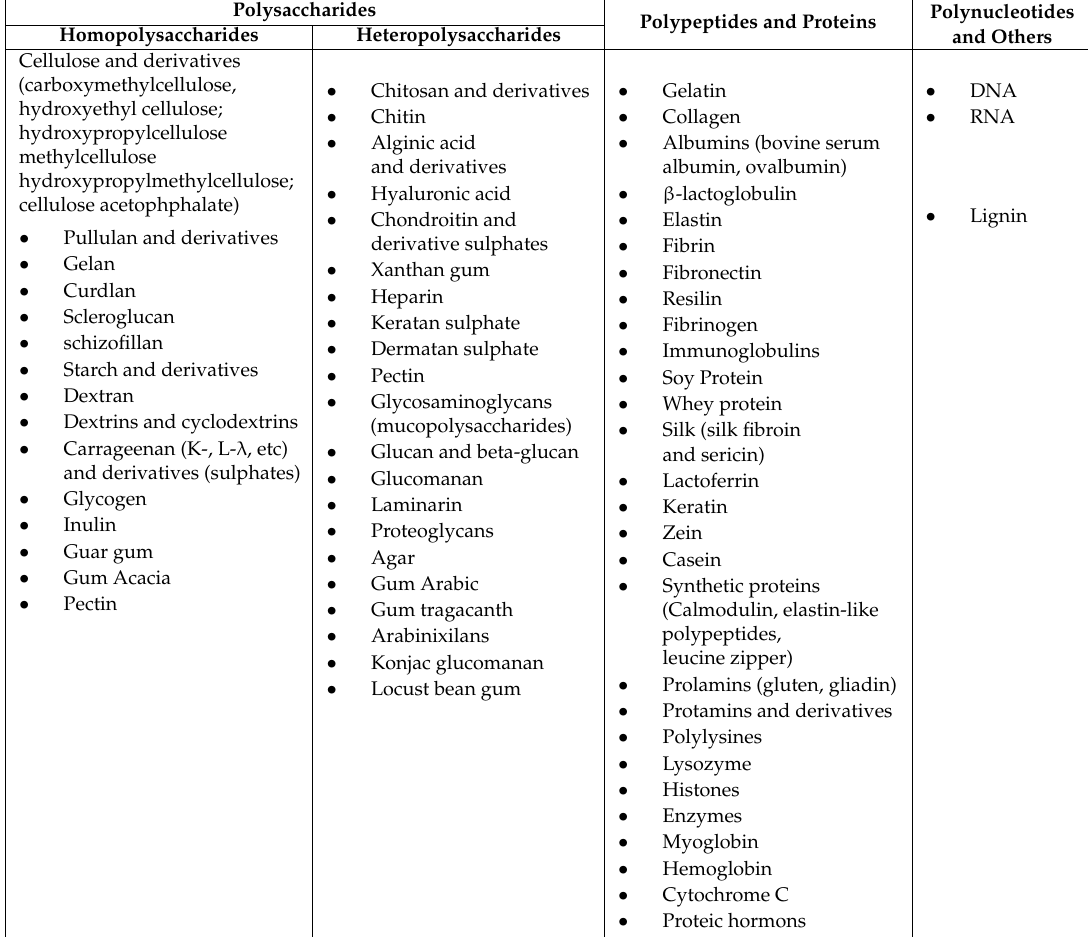
Table 1. Natural polymers used in organic hybrid hydrogels for medical